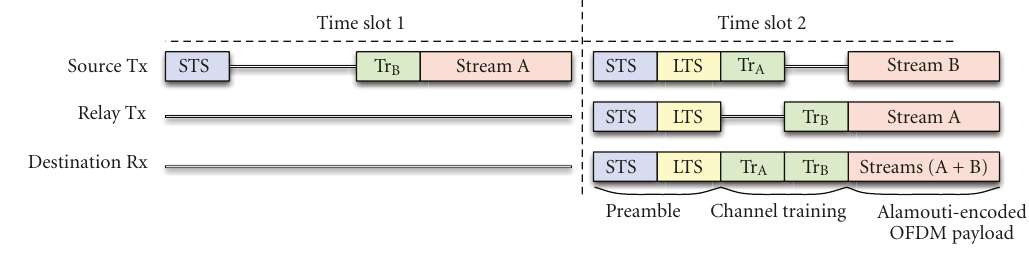
Figure 7: Physical layer frame